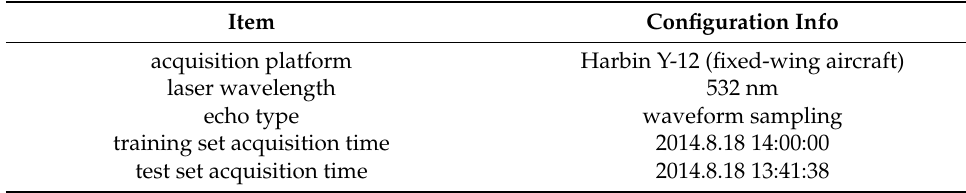
Table 2. Details of various data sets.